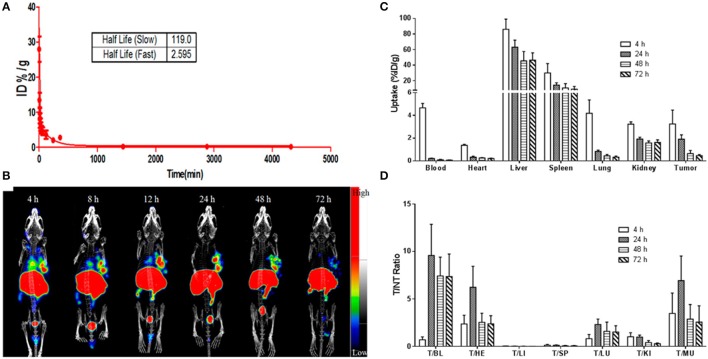
(A) The blood clearance curve of ICG@DPDCs-177Lu. (B) Antitumor and antimetastatic effects of PD-L1-PCI-Gd in mice with 4T1 tumors (n = 5) represting BLI imaging, tumor volume, and body weight. (C) and tumor-to-nontargeted tissue ratio (D) of ICG@DPDCs-177Lu in LLC bearing mice at 4, 24, 48, and 72 hpi (Jing et al., 2015).